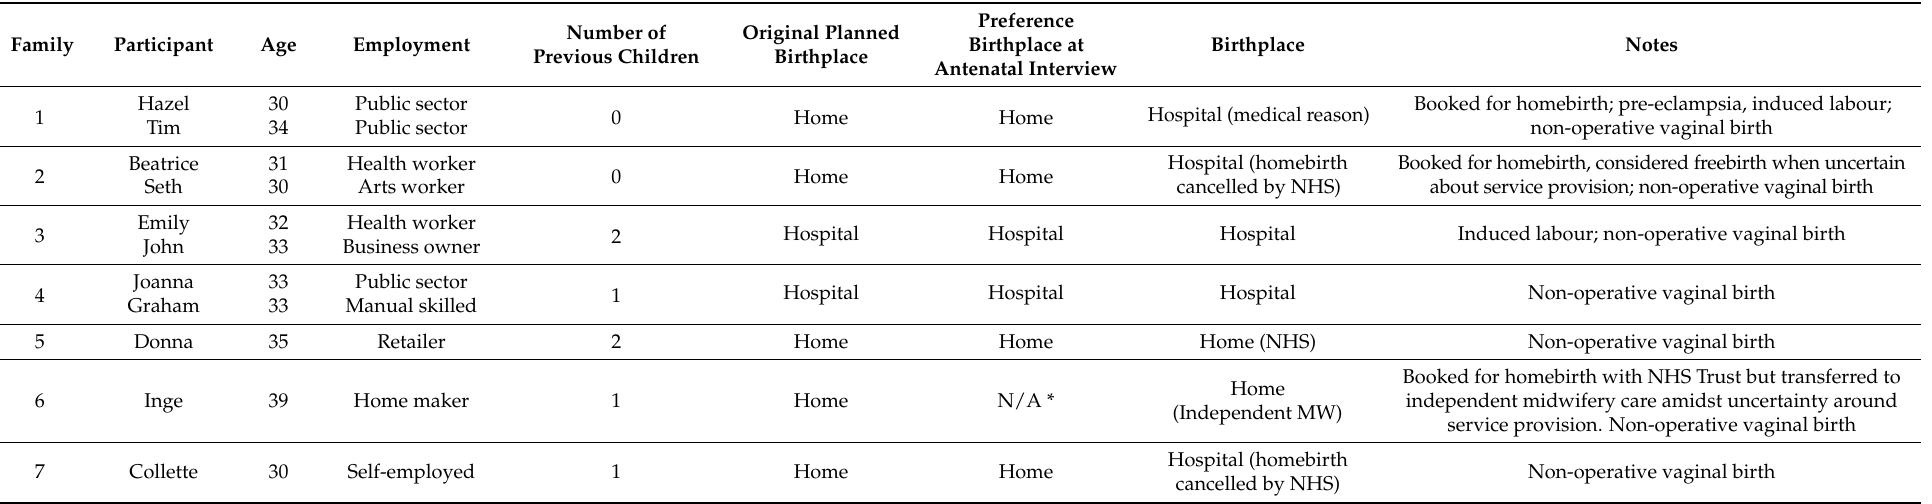
Table 1. Participant